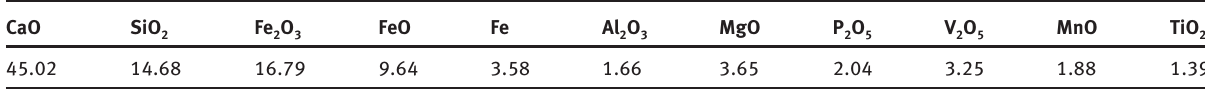
Table 1: Chemical composition of the original slag (mass%)